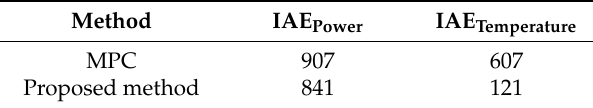
Table 2. Performance indices for Figure